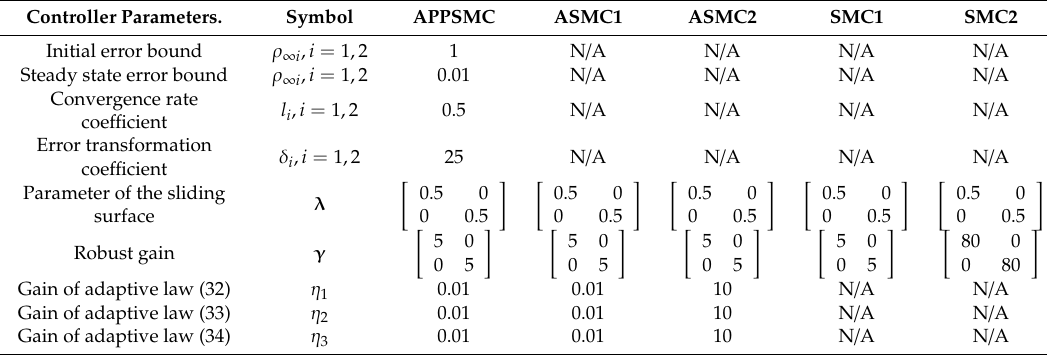
Table 3. Parameters of the proposed APPSMC